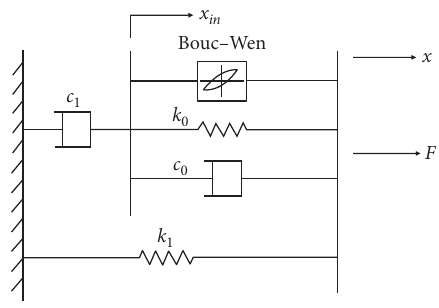
Figure 7: Modified Bouc–Wen model.